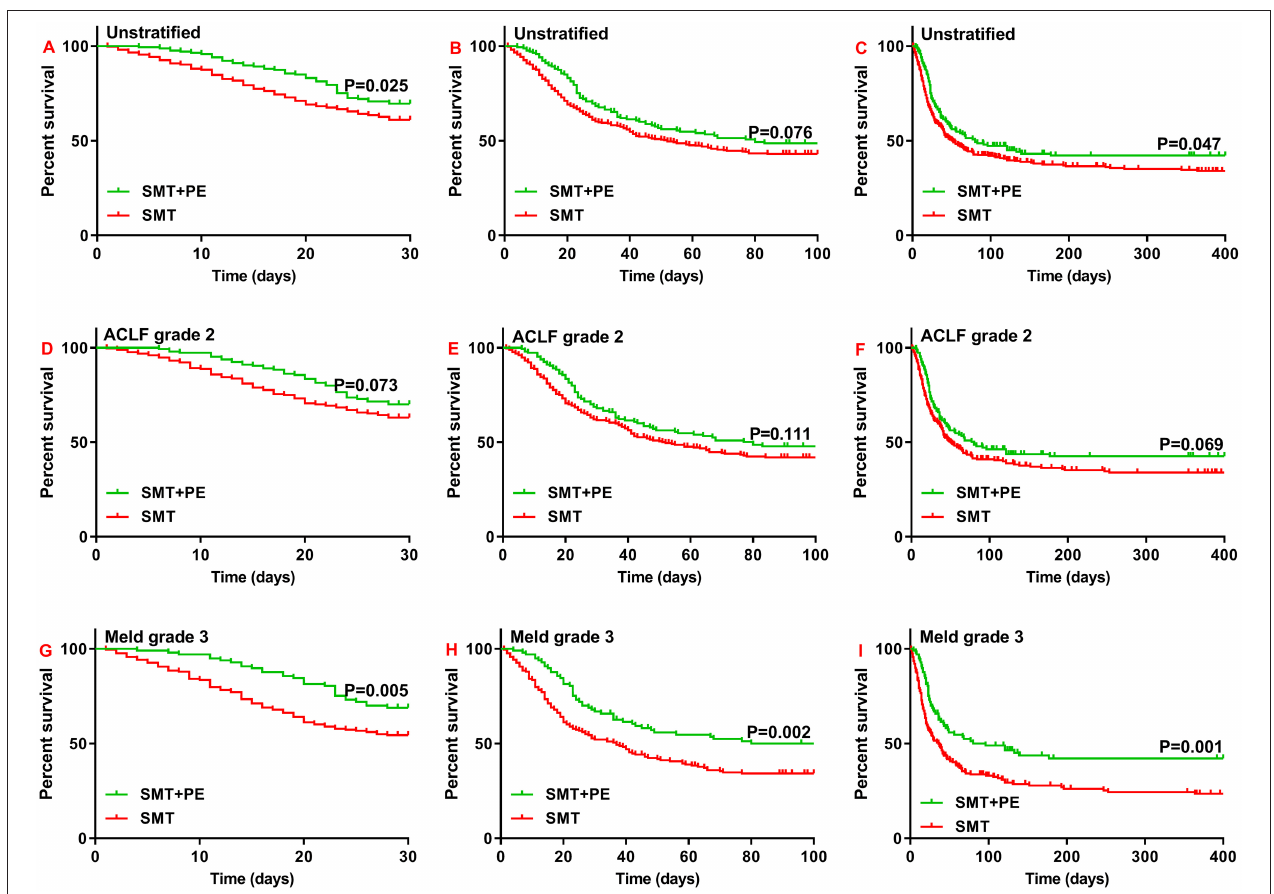
FIGURE 2 | Survival curves for patients with HBV-ACLF who received SMT alone or SMT + PE. (A–C) 28-day (A) , 90-day (B) , and 1-year (C) survival curves for patients with HBV-ACLF. (D–F) 28-day (D) , 90-day (E) , and 1-year (F) survival curves for HBV-ACLF patients with ACLF grade 2. (G–I) 28-day (G) , 90-day (H) , and 1-year (I) survival curves for HBV-ACLF patients with MELD scores of 30–40. SMT, standard medical therapy; PE, plasma exchange; HBV-ACLF, hepatitis B virus-associated acute-on-chronic liver